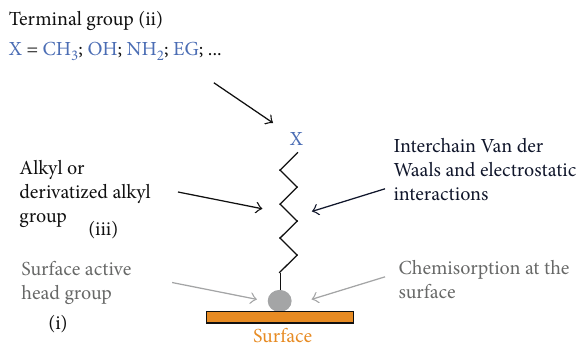
Figure 3: Schematic representation of a surfactant that can form a